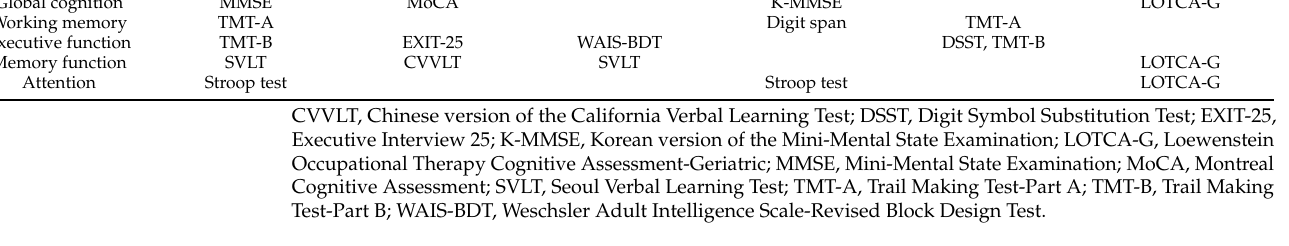
Table 2. Characteristics of the included